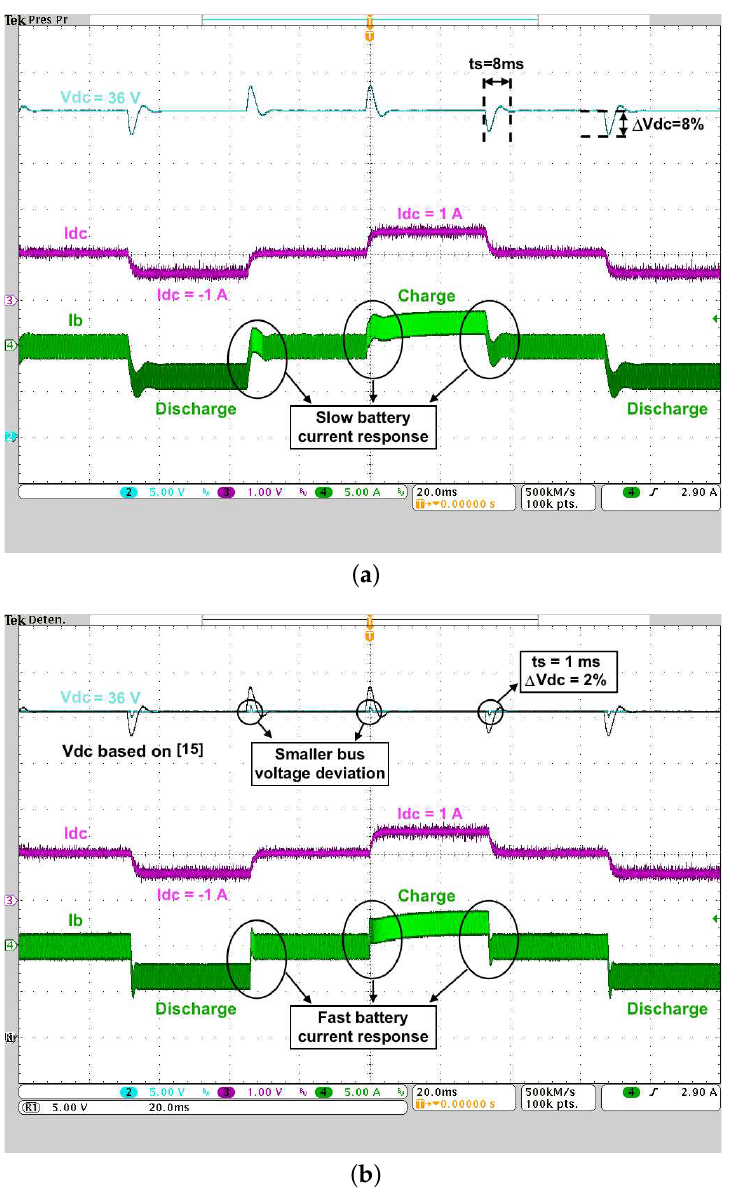
Figure 20. Experimental results for 1 A steps in the bus current. ( a ) DC bus voltage regulation with the SMC reported in [15]; ( b ) DC bus voltage regulation with the proposed